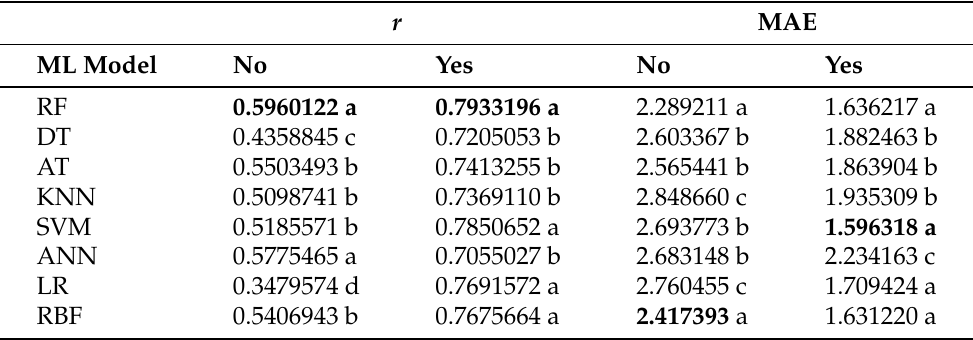
Table 3. Grouping of means by the Scott–Knott test for Pearson’s correlation coefficient ( r ) and mean absolute error (MAE) obtained with machine learning models using Total height (Ht, cm) results without “No” and with “Yes” the species. The best values are highlighted in bold. r